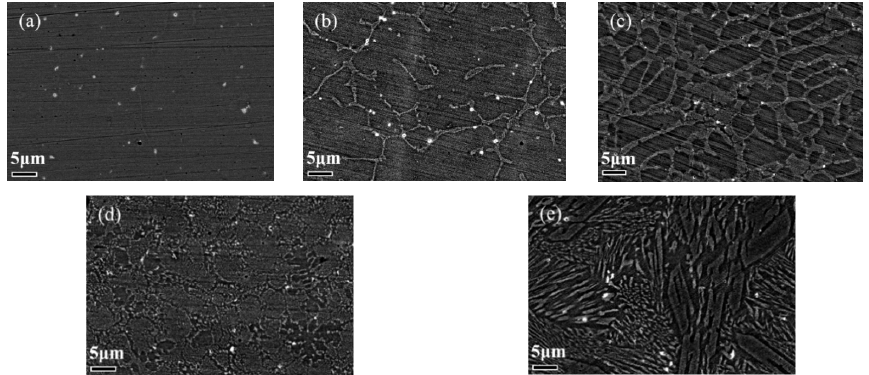
Figure 2. BSE morphology of cladding layers prepared using the same process and different Cr 3 C 2 content: ( a ) 0 wt.%, ( b ) 5 wt.%, ( c ) 15 wt.%, ( d ) 25 wt.%, and ( e ) 35 wt.%.